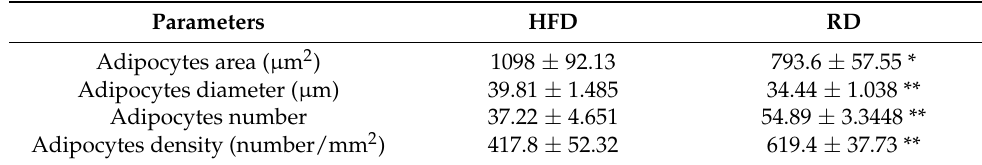
Figure 1. Histomorphological changes in the perirenal adipose tissue of dieting rabbits. Histomor- phological image of the perirenal adipose tissue from the high-fat diet (HFD) and restricted diet (RD) rabbits. Table 1. Adipocytes area, diameter, number, and density in high-fat diet (HFD) and restricted diet (RD)